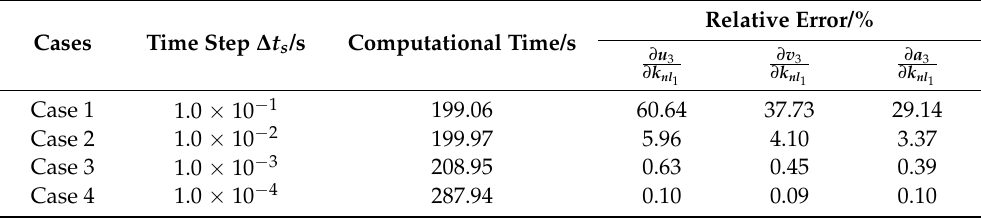
Table 1. The results of different time steps in DDM for the computational efficiency and relative error in MDOF system ( ∆ t d = 1.0 × 10 − 4